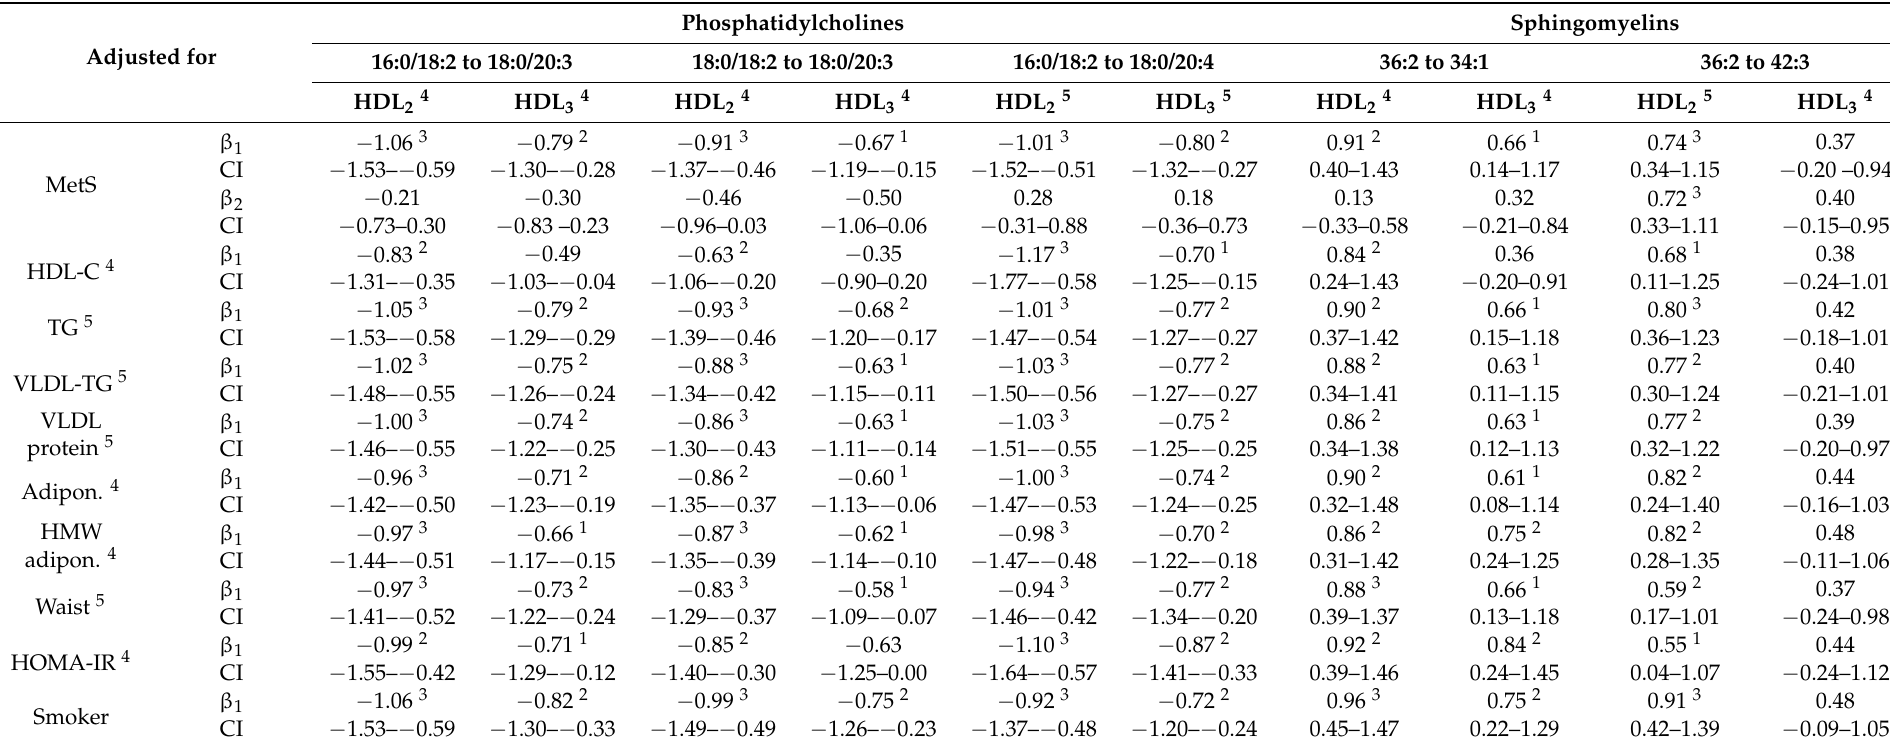
Table 2. Associations between selected phosphatidylcholine or sphingomyelin ratios and premature coronary heart disease (CHD) status adjusted for metabolic syndrome (MetS) status, parameters of MetS or cardiovascular risk